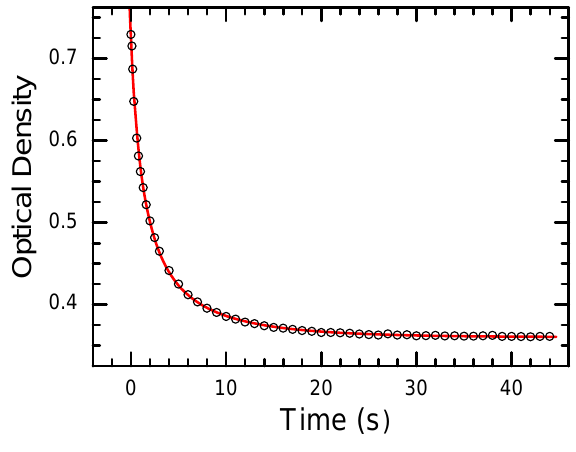
Figure 10. Restoration of the equilibrium concentration of shallow donor states after stoppage of excitation in the UV-VIS absorption band (at t = 0) in CdF crystal at T = 294 K. Points are experimental data; solid line represents an